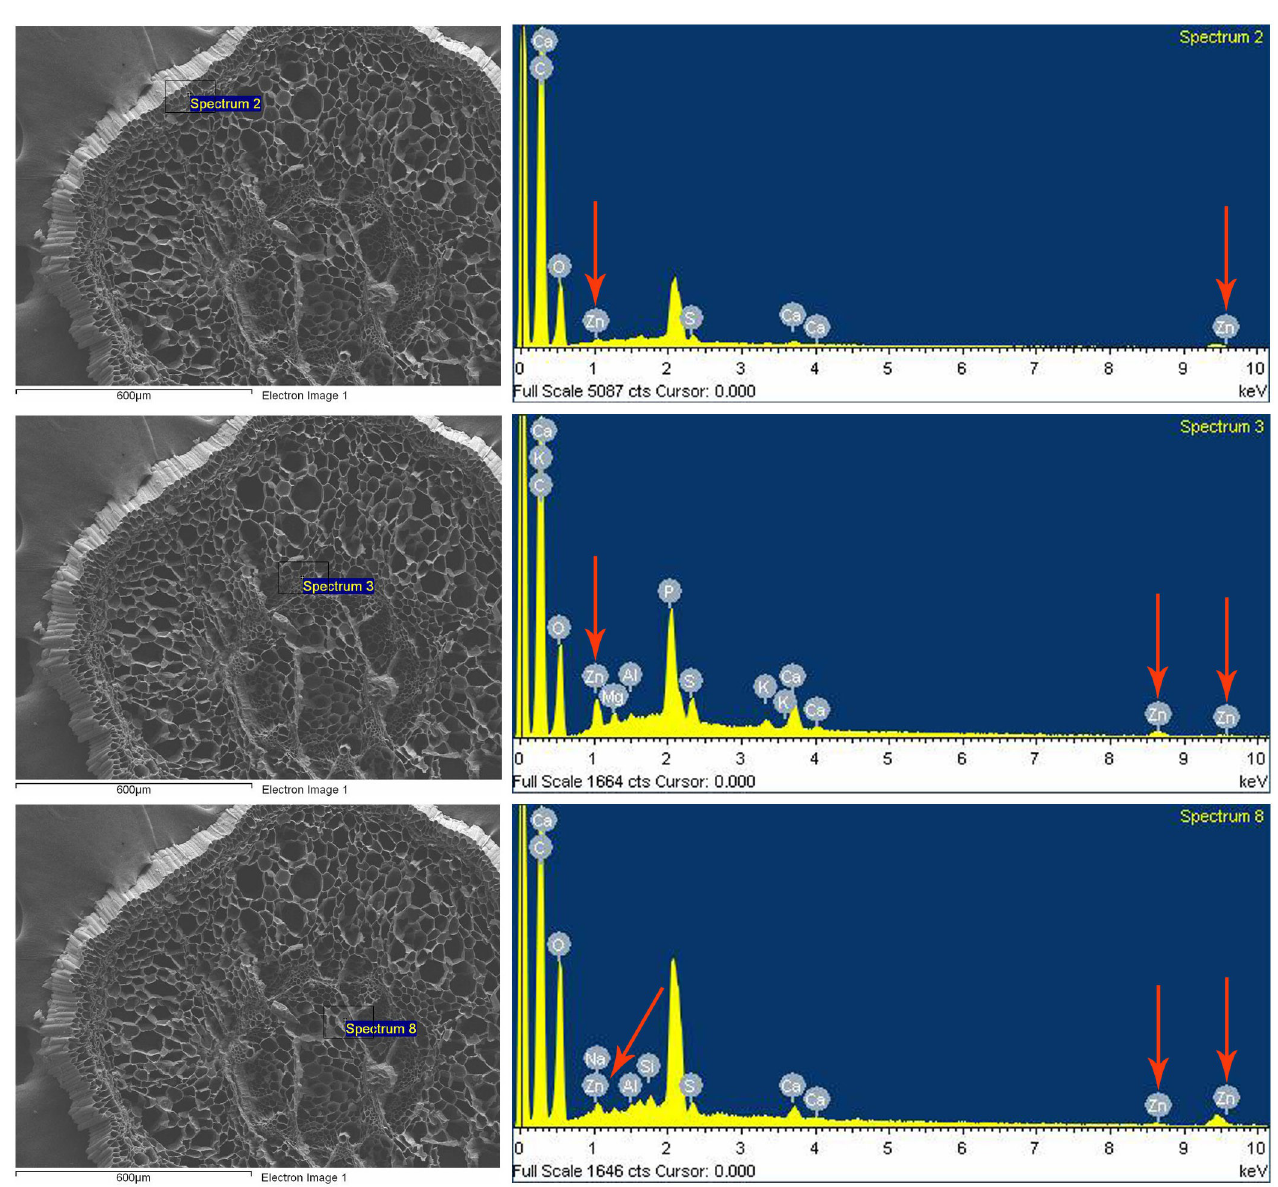
Fig 5. FEG SEM-EDXM of A . ilicifolius L. roots exposed to ZnSO 4 (4 mM). The SEM and EDX of three areas of root, spectrum 2 (exodermis and cortex), spectrum 3 (endodermis and vascular tissues) and spectrum 8 (pith).